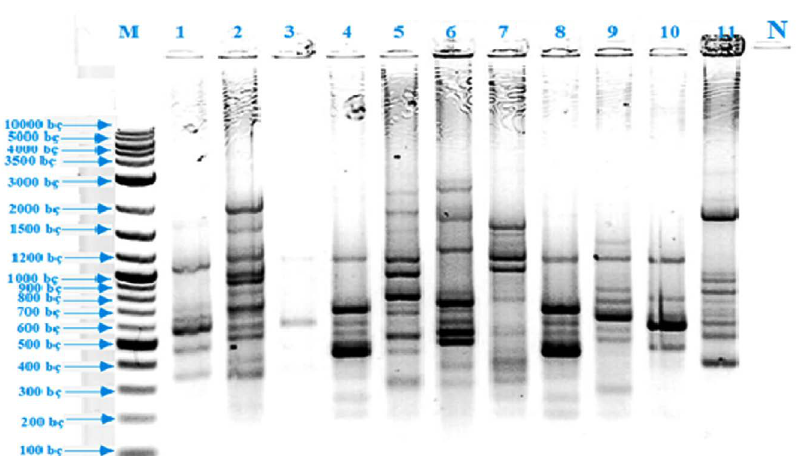
Fig. 2. BOX-PCR band profiles of thermophilic isolates (M: DNA Marker, 1: EA 2, 2: EA 8, 3: EA 4, 4: EA 7, 5: EA 1, 6: EA 11, 7: EA 9, 8: EA 3, 9: EA 5, 10: EA 6, 11: EA 10, 12: Negative